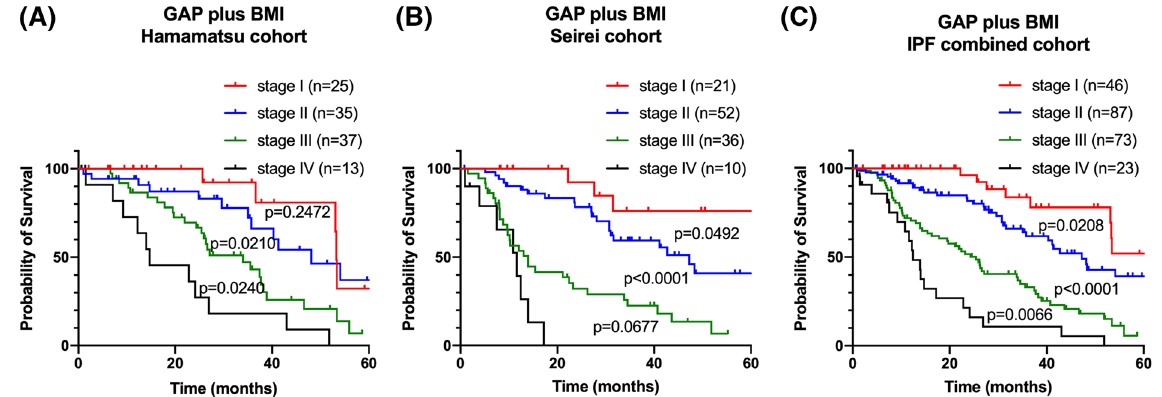
Figure 4. Prognostic classifications according to GAP plus BMI. Kaplan–Meier curves based on the data of the patients with IPF of the Hamamatsu cohort (A) , Seirei cohort (B) , and combined cohort (C) according to GAP plus BMI. P values were determined using the log-rank test. GAP Gender-Age-Physiology, BMI body mass index, IPF idiopathic pulmonary